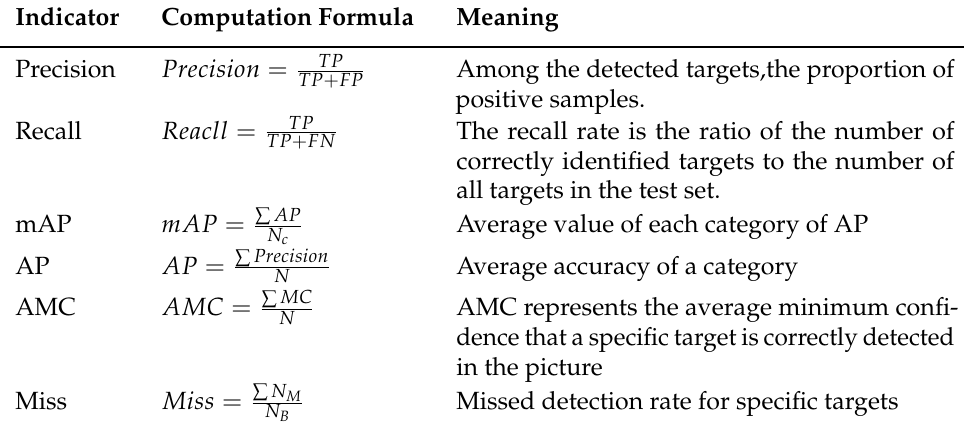
Table 1. Evaluation Indicators.